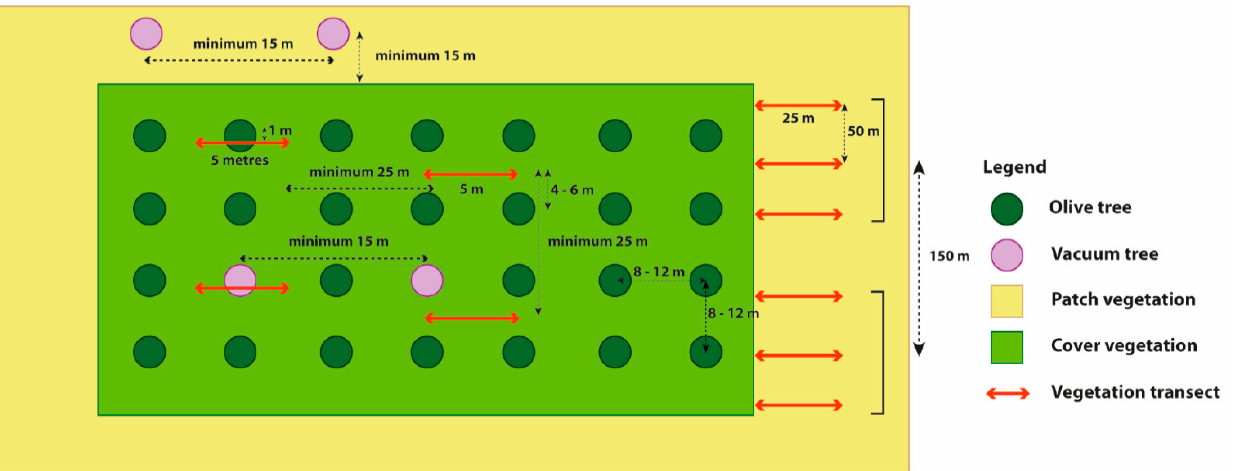
Figure 4. Experimental design diagrams in each farm for flora and vegetation, and Chrysopidae sampling.